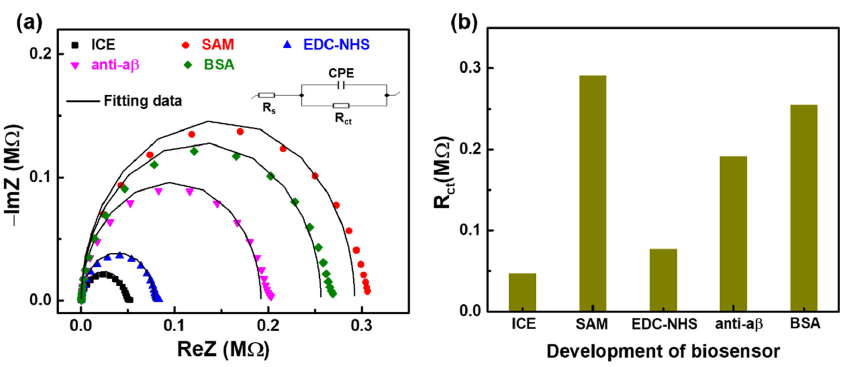
Figure 3. EIS results at each step of the development of biosensor anti-a β /SAM/ICE display in ( a ) Nyquist plots and ( b ) charge-transfer resistance (R ct ). Table 1. EIS parameters of the bare and modified ICE extrapolated by fitting the measured spectra to the equivalent circuit model shown in Figure 3a.